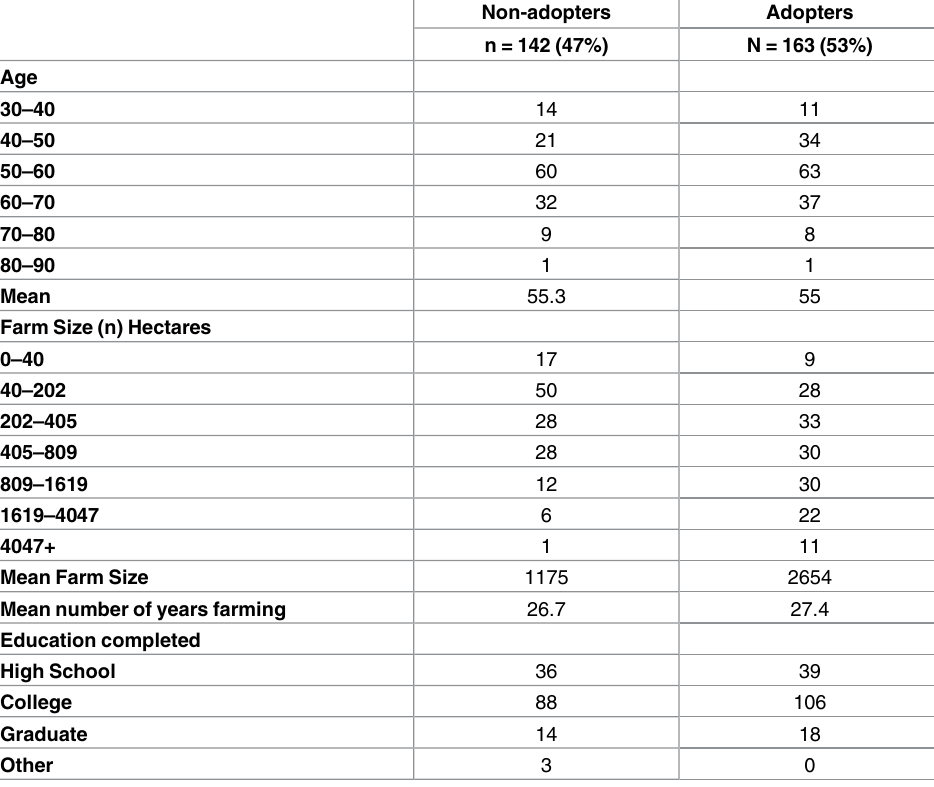
Table 1. Farmer demographics for non-adopters and adopters show difference in mean farm size and little difference between age, education and experience farming. For questionswhere responseswere reportedas a range, means were calculatedusing the middle of the